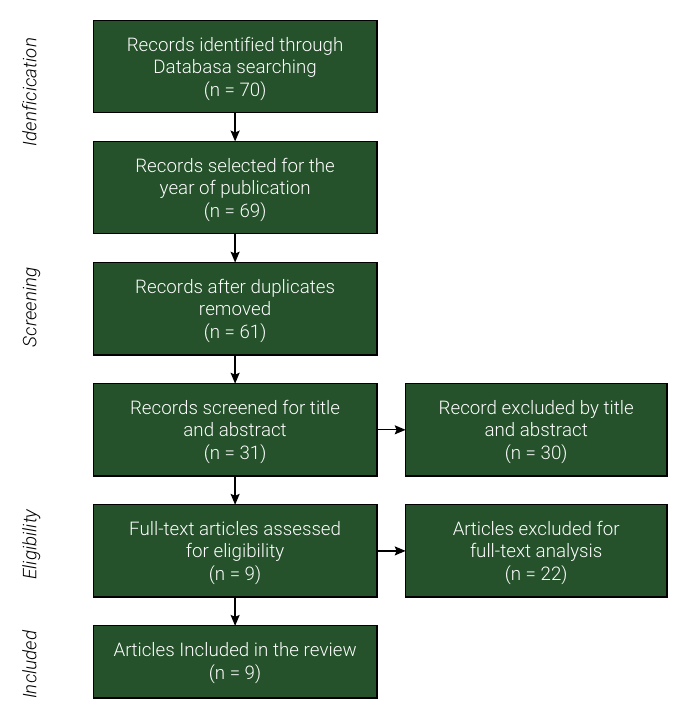
Figure 1. Flowchart of the study selection